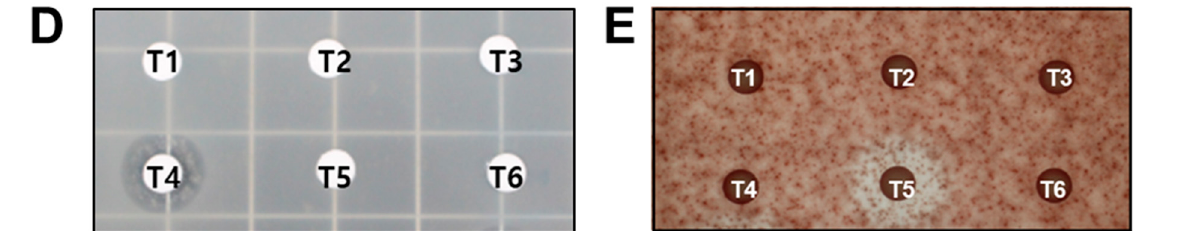
Figure 5. Characterization and identification of lipopeptides (CLPs) in butanol extracts of B. subtilis KB21. ( A ) Procedure for extraction of compounds from the cell-free supernatants. ( B ) Antifungal activity of crude extracts isolated from B. subtilis KB21. 1, Compounds extracted from the aqueous layer in Figure 5A; 2, Compounds extracted from the hexane solvent; 3, Compounds extracted from the ethyl acetate; 4, Compounds extracted from the butanol; 5, final aqueous solution. ( C ) Peaks of purified fractions analyzed by LC-MS/MS. ( D ) Inhibitory activity of purified fractions CLPs from butanolic extracts on C. acutatum spore growth. ( E ) Inhibitory activity of fractions CLPs on Fusarium oxysporum spore growth. T1, T2, T3, T4, T5, purified fractions CLPs from B. substilis KB21; T6, methanol control.